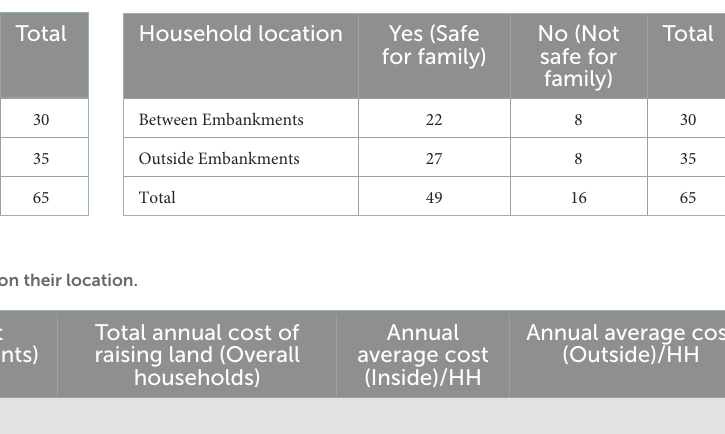
TABLE 8 Household responses on the safety of their family in their current location.